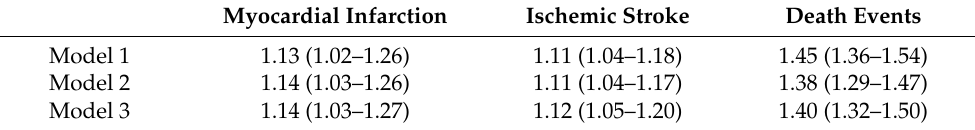
Model 1: Unadjusted. Model 2: Adjusted for age and sex. Model 3: Adjusted for age, sex, body mass index, comorbidities, smoking, walking days per week, osteoporosis, and